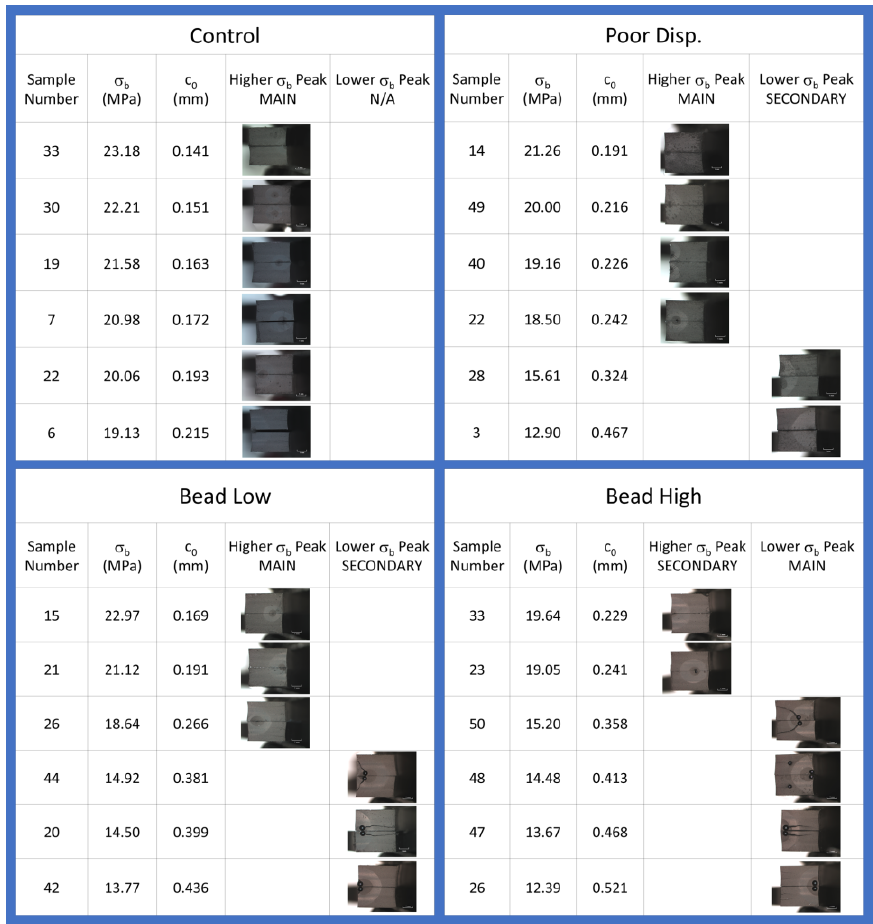
Figure 8. Representative fracture surfaces for tensile test specimens (two matching fracture sides shown stacked in mirror form for each) with corresponding values of σ b and c 0 .